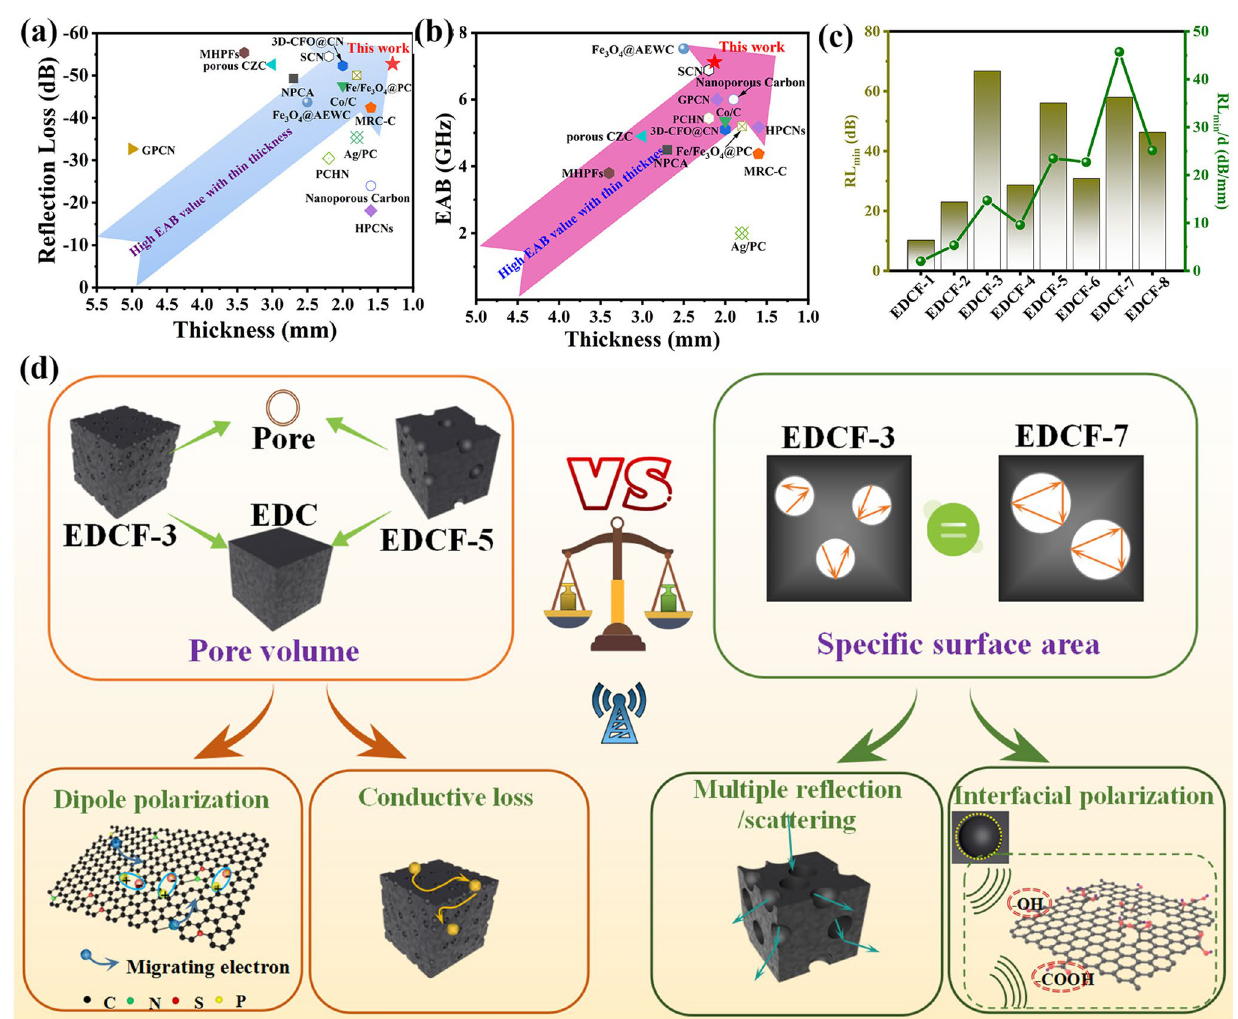
Fig. 6 a RL min and b EAB versus thickness of carbon-based absorbing materials reported recently; c the ratio of RL min to corresponding match- ing thickness of various EDCF samples; d schematic diagram of electromagnetic attenuation strategies for EDCF